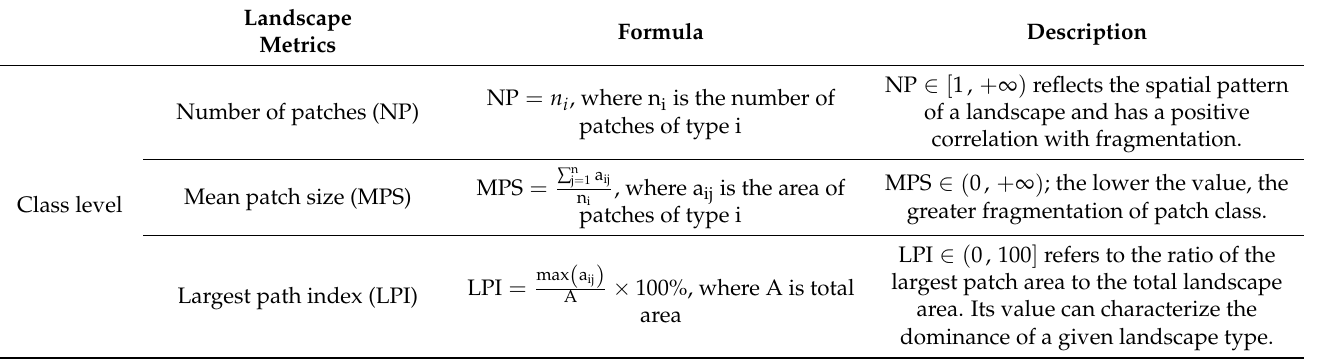
Table 1. Landscape indices used in this